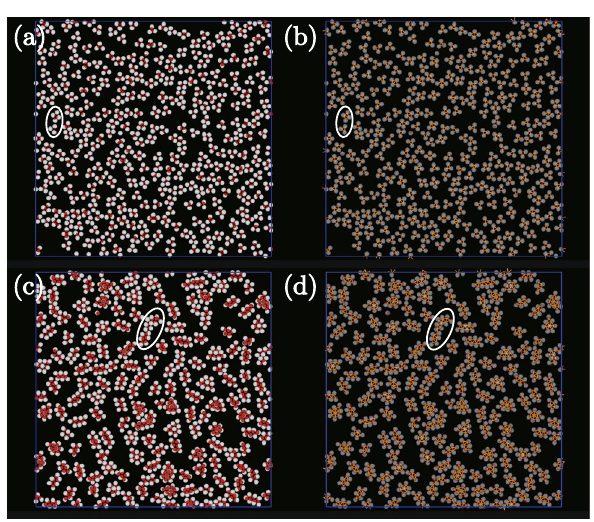
Figure 3. As for Fig. 2 but with ( l , q ) set to (0.20, 1.25) in ( a ) and ( b ), and (0.45, 1.25) in ( c ) and ( d